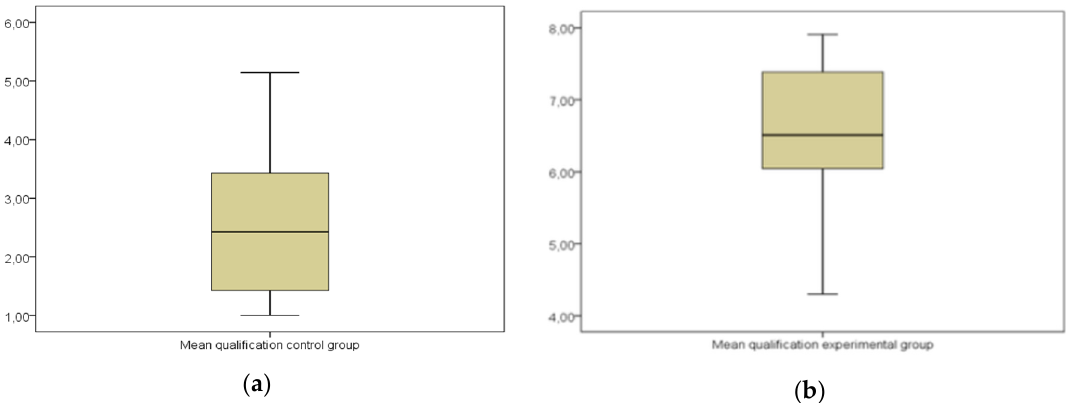
Figure 4. Box plots of the mean qualifictions. ( a ) Box plots of the mean qualifications in the post-test in the control group; ( b ) Box plots of the mean qualifications in the post-test in the experimental group.